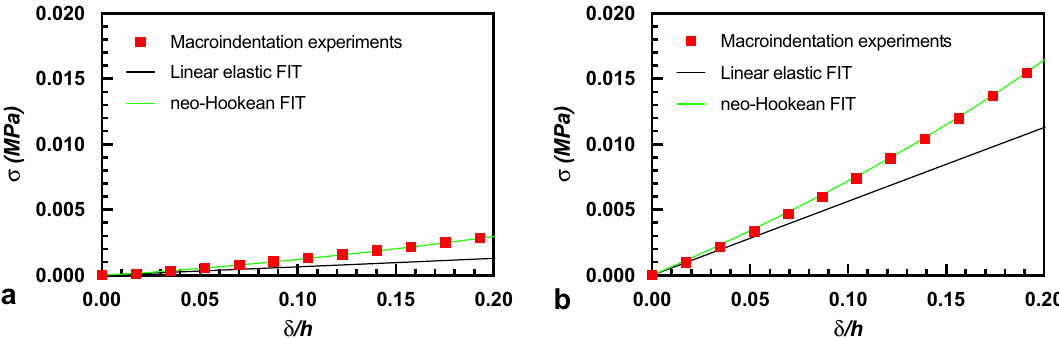
Figure 3. ( a , b ) Stress–strain curves obtained through uniform compression for soft PAA2 ( a ) and stiff PAA6 ( b ) hydrogels. The experimental results are better fitted by a Neo-Hookean constitutive behavior than by linear elasticity.